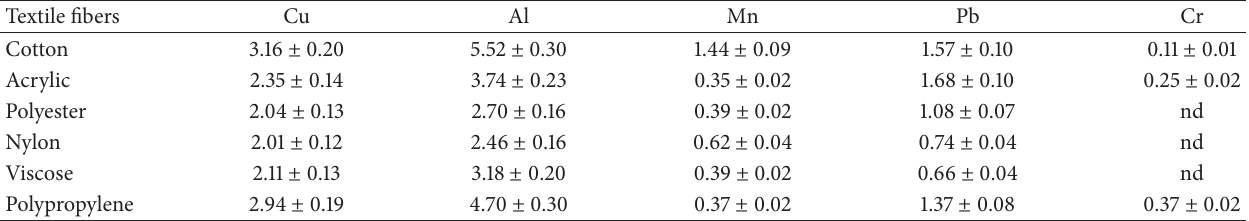
Table 4: Heavy metal contents (mg kg −1 ) in various textile fibers after extraction in the artificial sweat solution (average of replicates ± standard deviation).